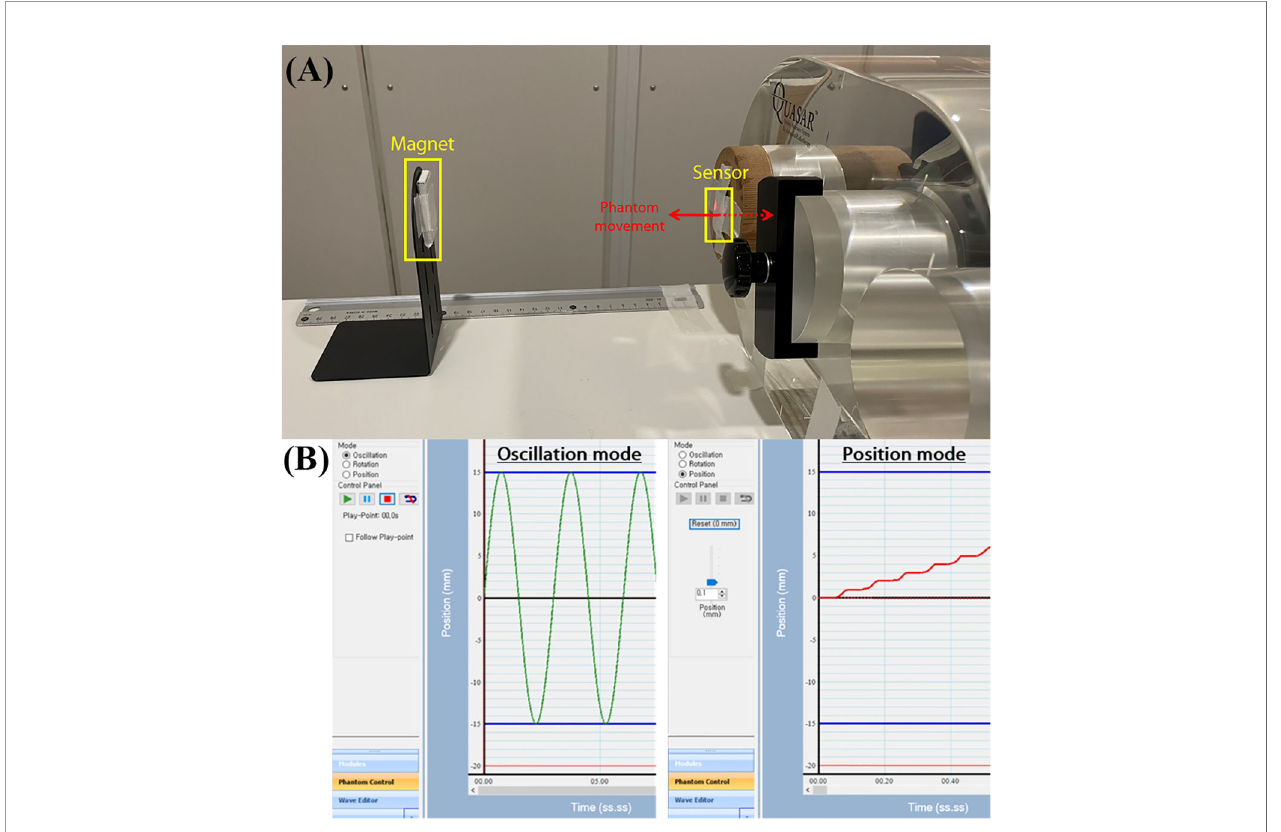
FIGURE 3 | The experimental setup for sensor evaluation: (A) QUASAR Motion Phantom attaching the sensor to surface of the insert and the magnet aligned with sensor, (B) the phantom movement modes i.e., oscillation mode and position